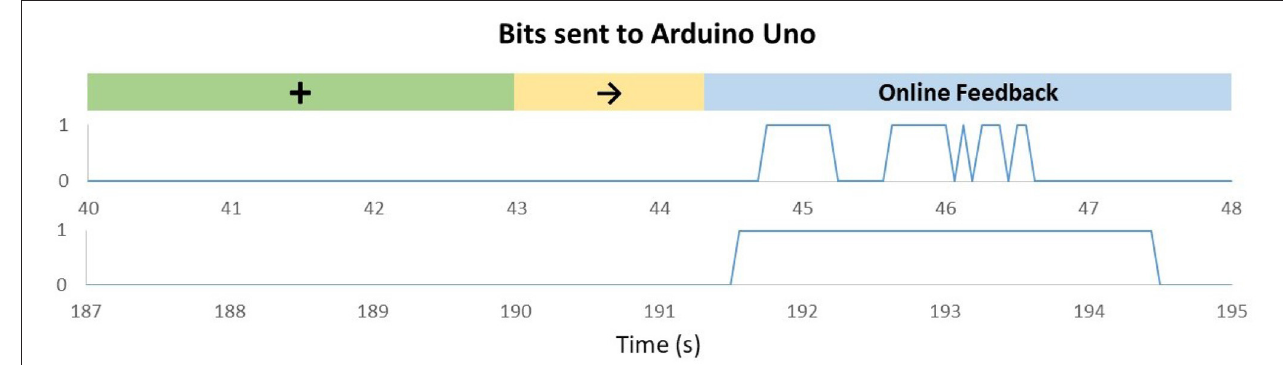
FIGURE 11 | Bits sent to Arduino Uno according to OpenVibe (OV) algorithm outputs in trials with a right arrow [motor imagery (MI) of the right hand]. The green mark represents the moment in which the cross appears on the screen. The yellow mark represents the moment in which the cue to class 2 appears on the screen. The value “0” means the actuators are braked, and the value “1” means the actuators are activated. Upper graph: Trial recorded between 40 and 48 s showing that the feedback can work in a non-continuous mode, according to the decoding received from the MI. Bottom graphic: Trial recorded between 187 and 195 s.